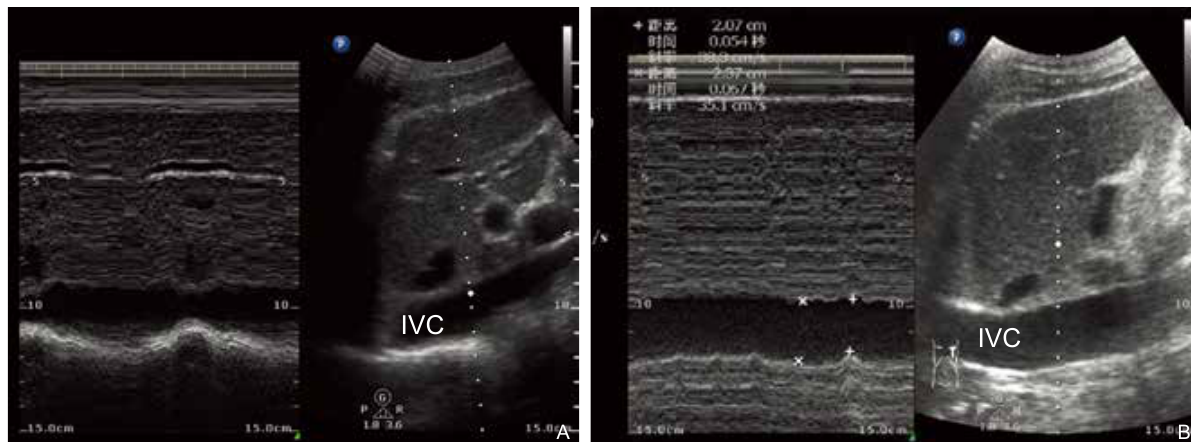
Figure 7 The image of inferior vena cava (IVC) is usually obtained by subxiphoid view or subcostal view in supine position. The diameter of IVC and its variability between inspiration and expiration can reflect the pressure of left atrium, which could further be used to evaluate the volume state and liquid responsiveness. Sample volume is usually taken at a distance of 2cm from the right atrium entrance. The measurement is completed on M-mode sonography, to ensure the accuracy for identifying the breath phase. (A) Normal IVC with significant respiratory variability of inner diameter. (B) A patient on ventilator, and the IVC diameter is significantly widened with the respiratory variability reduced, indicating fluid